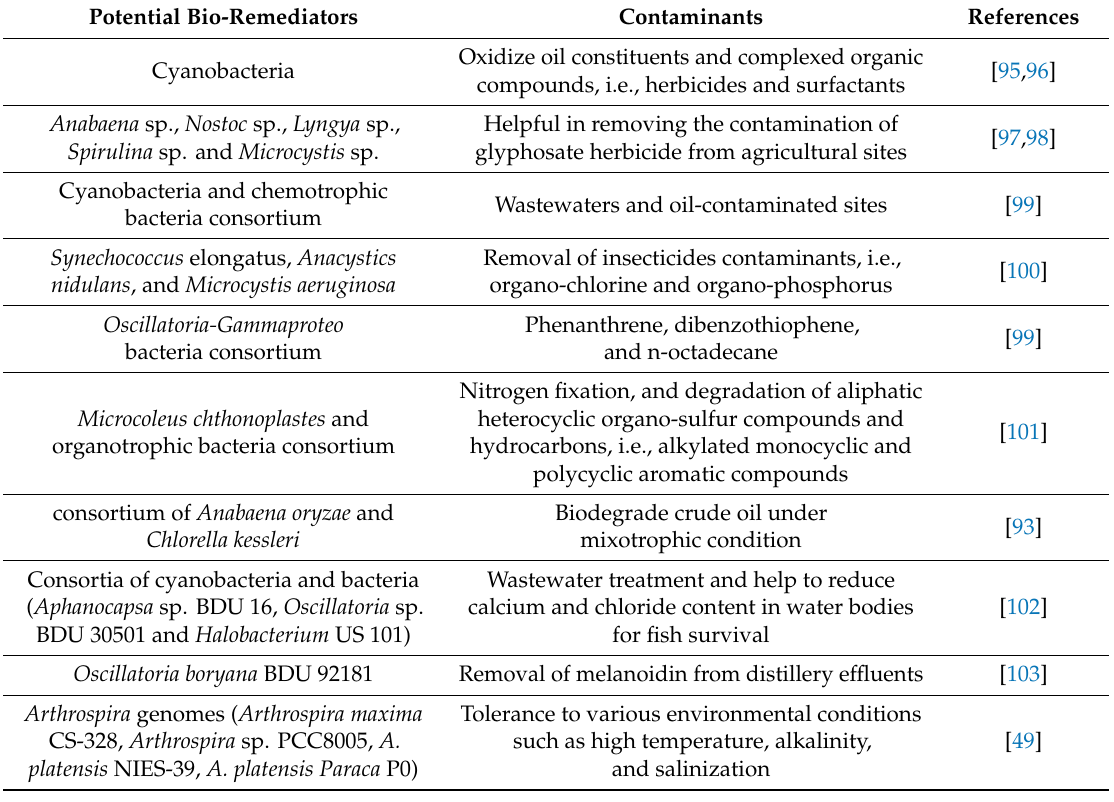
Table 2. Cyanobacterial species that can have the potential for bioremediation of numerous